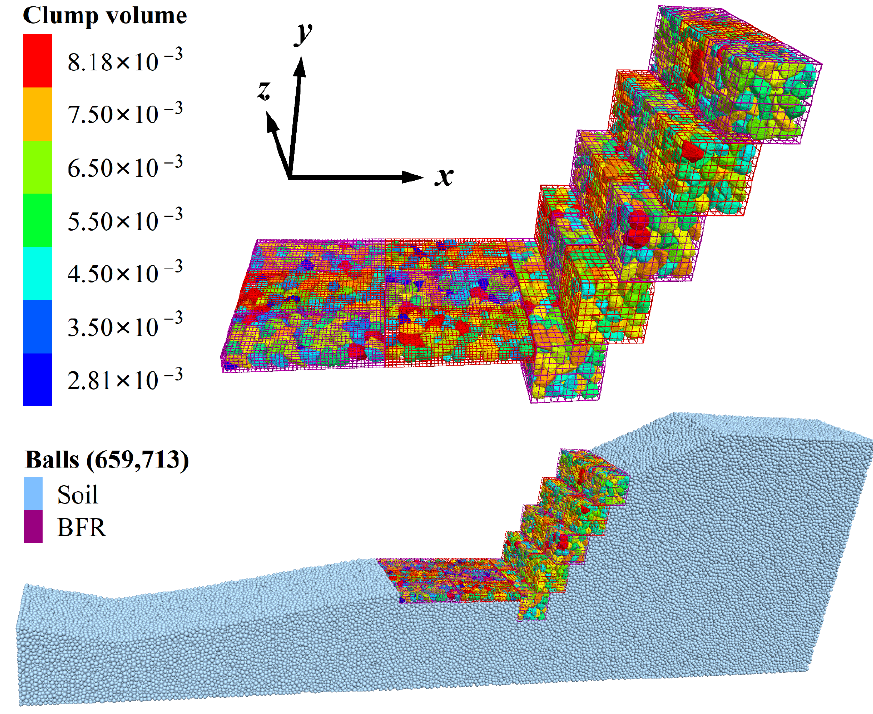
Figure 15. 3D DEM model of the BFR gabion slope. The unit of volume is m 3 .